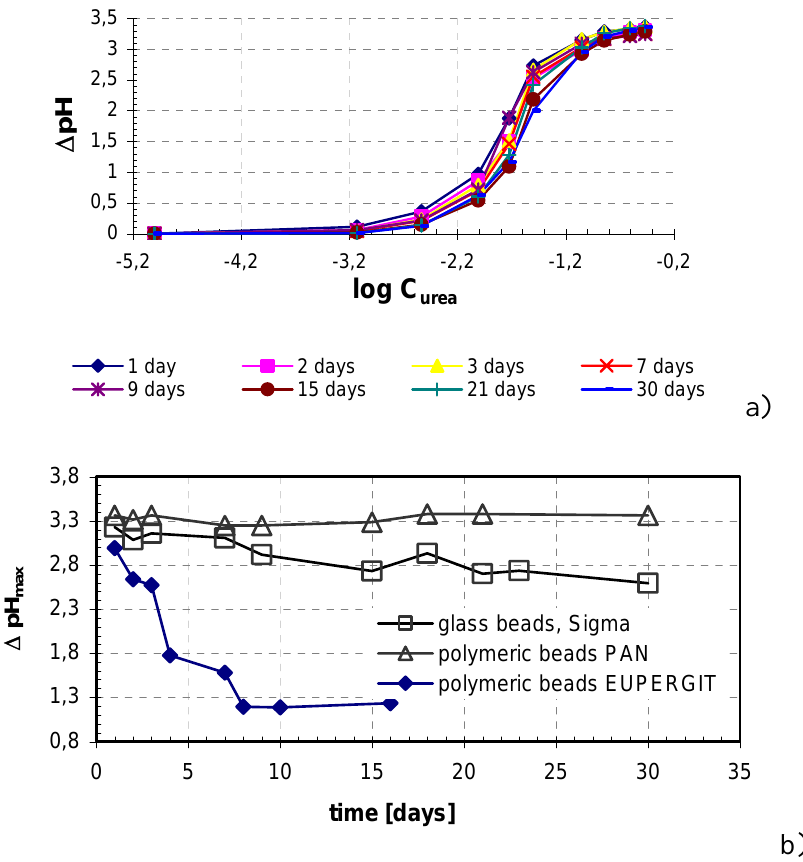
Figure 6. Time dependence of the calibration curves for the batch type microreactor filled with urease immobilised onto PAN-beads (a) and changes of the output signal (pH reactors with immobilised urease: the batch type microreactors filled with EUPERGIT, PAN and glass-APTS-modified